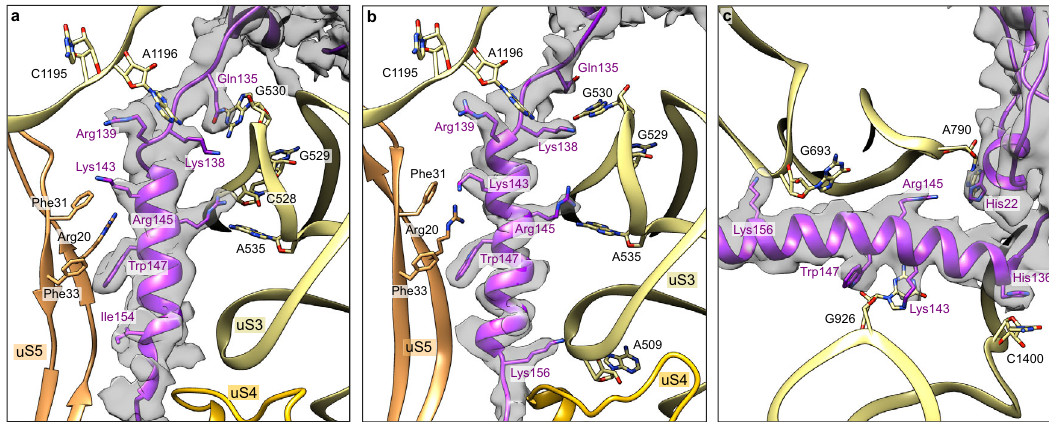
Fig. 4 Interactions between SmpB ’ s C-terminal tail and the 30S small ribosomal subunit. Each panel details the contacts that stabilize the C-terminal tail of SmpB in the mRNA channel during the a pre-accommodation, b accommodation, and c translocation states. SmpB is purple, 16S rRNA is khaki, and the ribosomal proteins uS4 and uS5 are gold and sandy brown, respectively. Residues and nucleotides within 4 Å of each other are indicated, and the cryo- electron density map of SmpB is